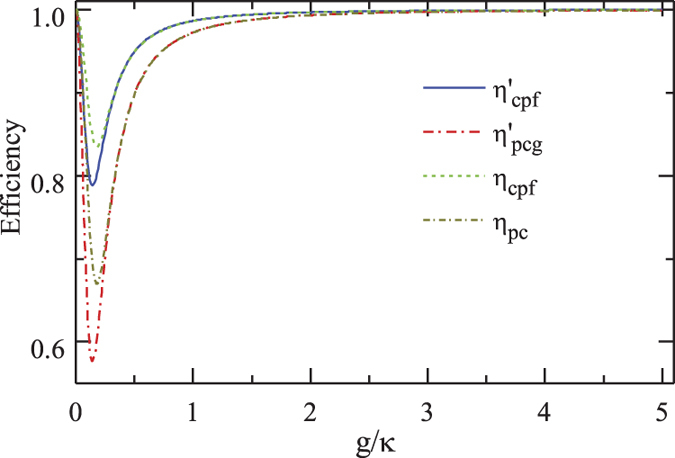
Efficiencies of our CPF gate and PCG vs the scaled coupling rate. and  is performed with the scaled detuning δ′/κ = 0.0283 and γ/κ = 0.0566, ηcpf and ηpcg are performed with δ′/κ = γ/κ = 0.0566.